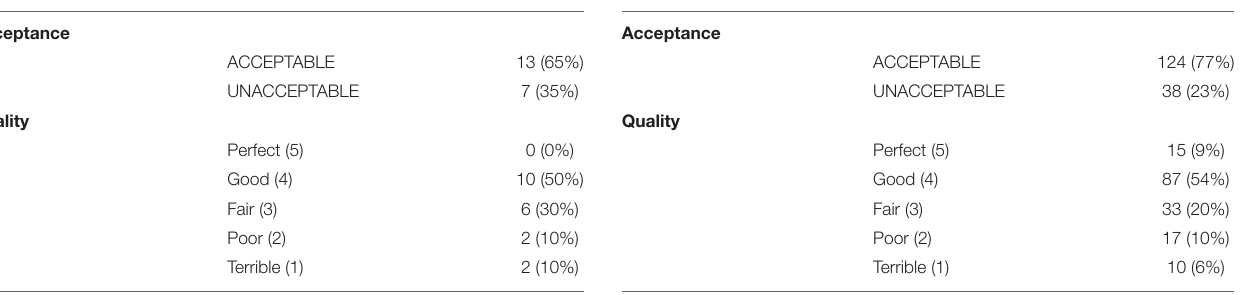
TABLE 4 | Results of annotations entered in EASE in clinical practice.